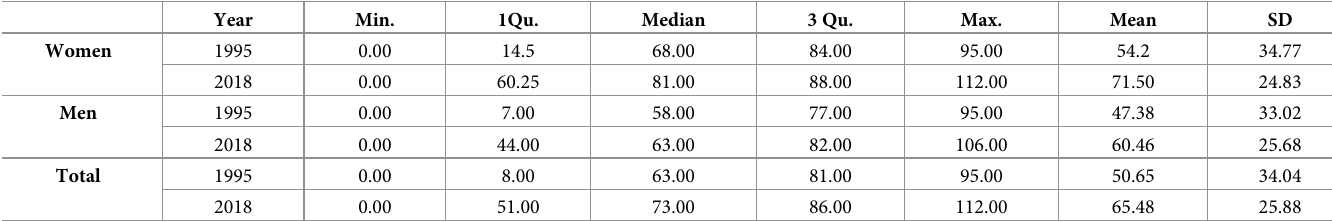
Table 3. Age distribution of deaths in the years 1995 to